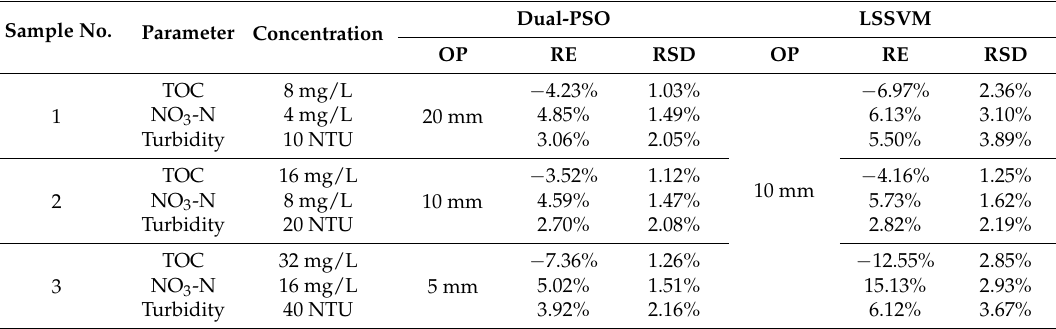
Table 1. Comparison of multi-parameter quantification with Dual-PSO and LSSVM. Sample No. Figure 8. The fitting curve of measured absorbance curve in multi-parameter quantification.